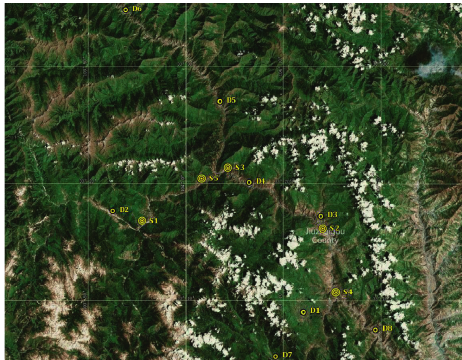
Figure 2: Location of emergency management. Table 2: Basic information of temporary inventory site.